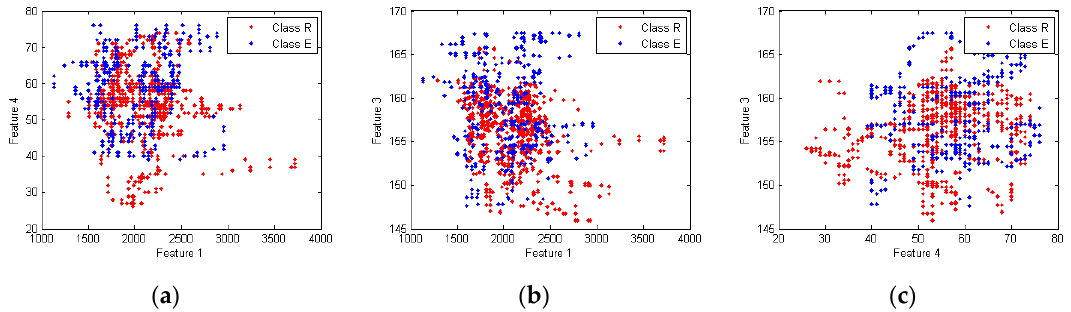
Figure 8. Scatter plots of selected features: ( a ) Feature 4 vs. Feature 1; ( b ) Feature 3 vs. Feature 1; ( c ) Feature 3 vs. Feature 4.